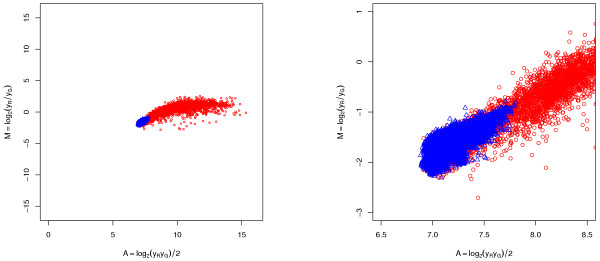
Transformation of background signal. Left: An M versus A scatter plot where background signals (blue triangles) and foreground signals (red circles) lye along the same curve, which is evidence that both have been transformed identically. Right: A zoom-in of the left graph. Data is from [50].